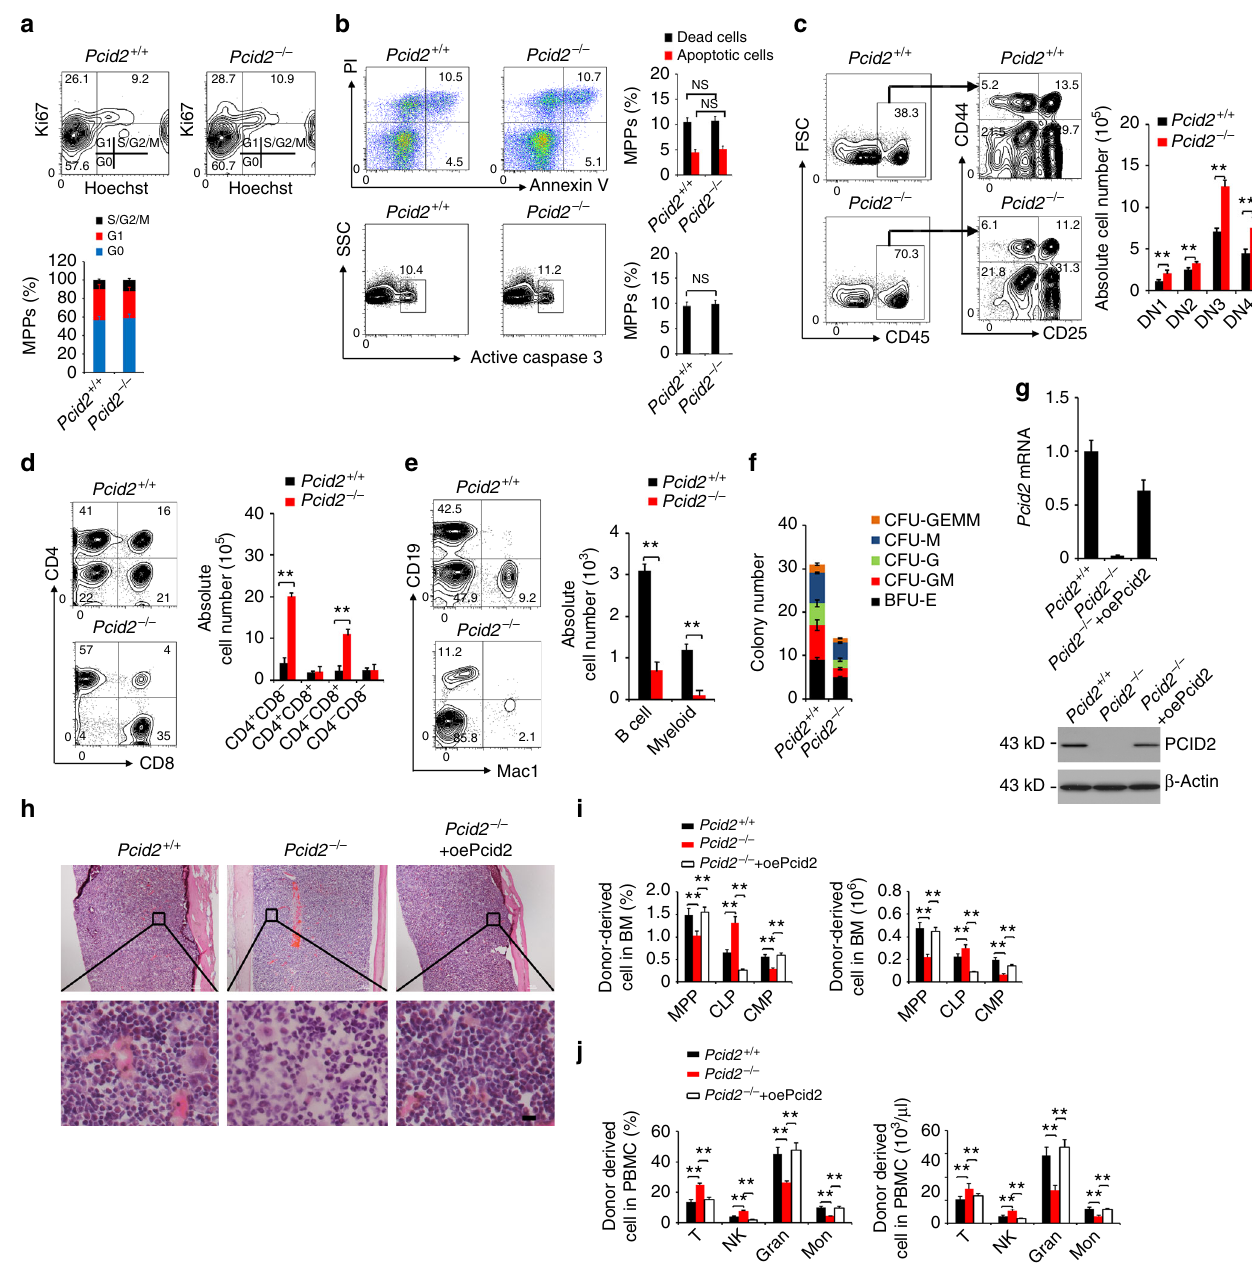
Fig. 2 Pcid2 -de fi cient MPPs prefer to differentiate into lymphoid cells but not myeloid cells. a Cell cycle analysis of MPPs from Pcid2 +/+ and Pcid2 − / − mice. Cells were stained by Ki67 and Hoechst 33342 followed by fl ow cytometry. Percentages of cell cycle distributions were calculated and shown as means ± S.D. b MPPs from Pcid2 +/+ and Pcid2 − / − mice were stained with Annexin V/PI or detected by active caspase 3. NS no signi fi cance. c Lymphoid-primed multipotent progenitors (LMPP) were sorted and co-cultured with OP9-DL1 stromal cells in the presence of Flt3-ligand and IL-7. After 14 days, cells were harvested and analysed by fl ow cytometry. d Cells were sorted and cultured as in c in the presence of Flt3-ligand and IL-7 and used Flt3 ligand alone thereafter. After 4 days, cells were harvested and analysed by fl ow cytometry. CD45-positive indicated cells were counted as absolute cell number and were shown as means ± S.D. ** P < 0.01. e Multipotent progenitors (MPP) from BM of Pcid2 +/+ or Pcid2 − / − mice were co-cultured with OP9 stromal cells in the presence of Flt3-ligand, IL-7 and SCF, followed by fl ow cytometry. CD45-positive cells were counted as absolute cell numbers and were shown as means ± SD. ** P < 0.01. f MPPs from BM of Pcid2 +/+ or Pcid2 − / − mice were cultured in methocult medium for colony-forming cell (CFC) formation assays. CFU-GEMM, CFU-M, CFU-G, CFU-GM and BFU-E colonies were counted, respectively. Results are shown as means ± S.D. n = 5 for each group. g 1 × 10 3 HSCs were isolated from BM of Pcid2 +/+ or Pcid2 − / − mice and infected with pMY-GFP-Pcid2 (oePcid2) or empty vector containing retrovirus and transplanted into lethally irradiated recipient mice together with 5 × 10 6 helper cells. Pcid2 restoration was con fi rmed by quantatitive PCR and immunoblotting. h Paraf fi n sections from the femurs were stained with H&E 8 weeks after transplantation. Scale bars, 20 μ m. i BM progenitor populations from donor mice (GFP + ) were analysed 8 weeks after transplantation. n = 6 for each group. ** P < 0.01. j Peripheral blood cell populations from donor mice were analysed 8 weeks after transplantation. n = 6 for each group. ** P < 0.01. Student ’ s t -test was used as statistical analysis. Data are representative of